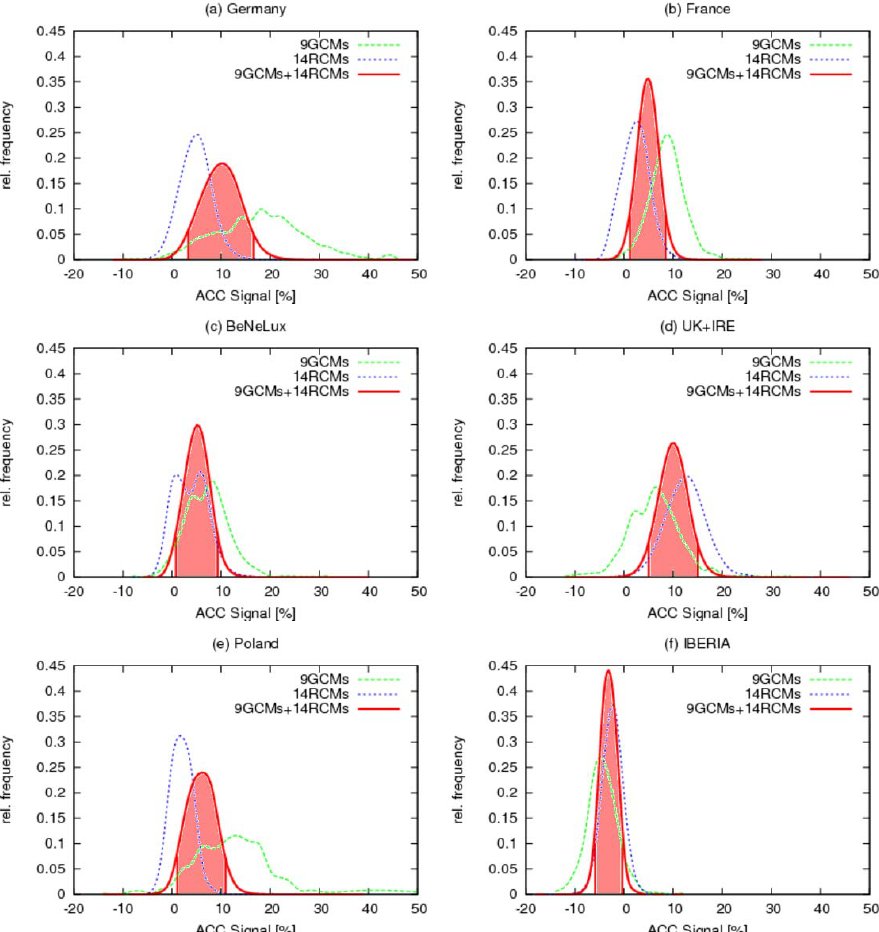
Fig. A1. Probability of loss potential changes for the future climate period in the middle of 21C (2021–2050) compared to 20C (1961–2000) without adaptation of the loss threshold, based on all possible model combinations of GCMs (green curve), RCMs (blue curve) and all available GCM and RCM scenario (red curve) simulations. The red shaded areas mark the range where 90% of the change signals (between 5 th and 95 th percentile) based on all model combinations are found.